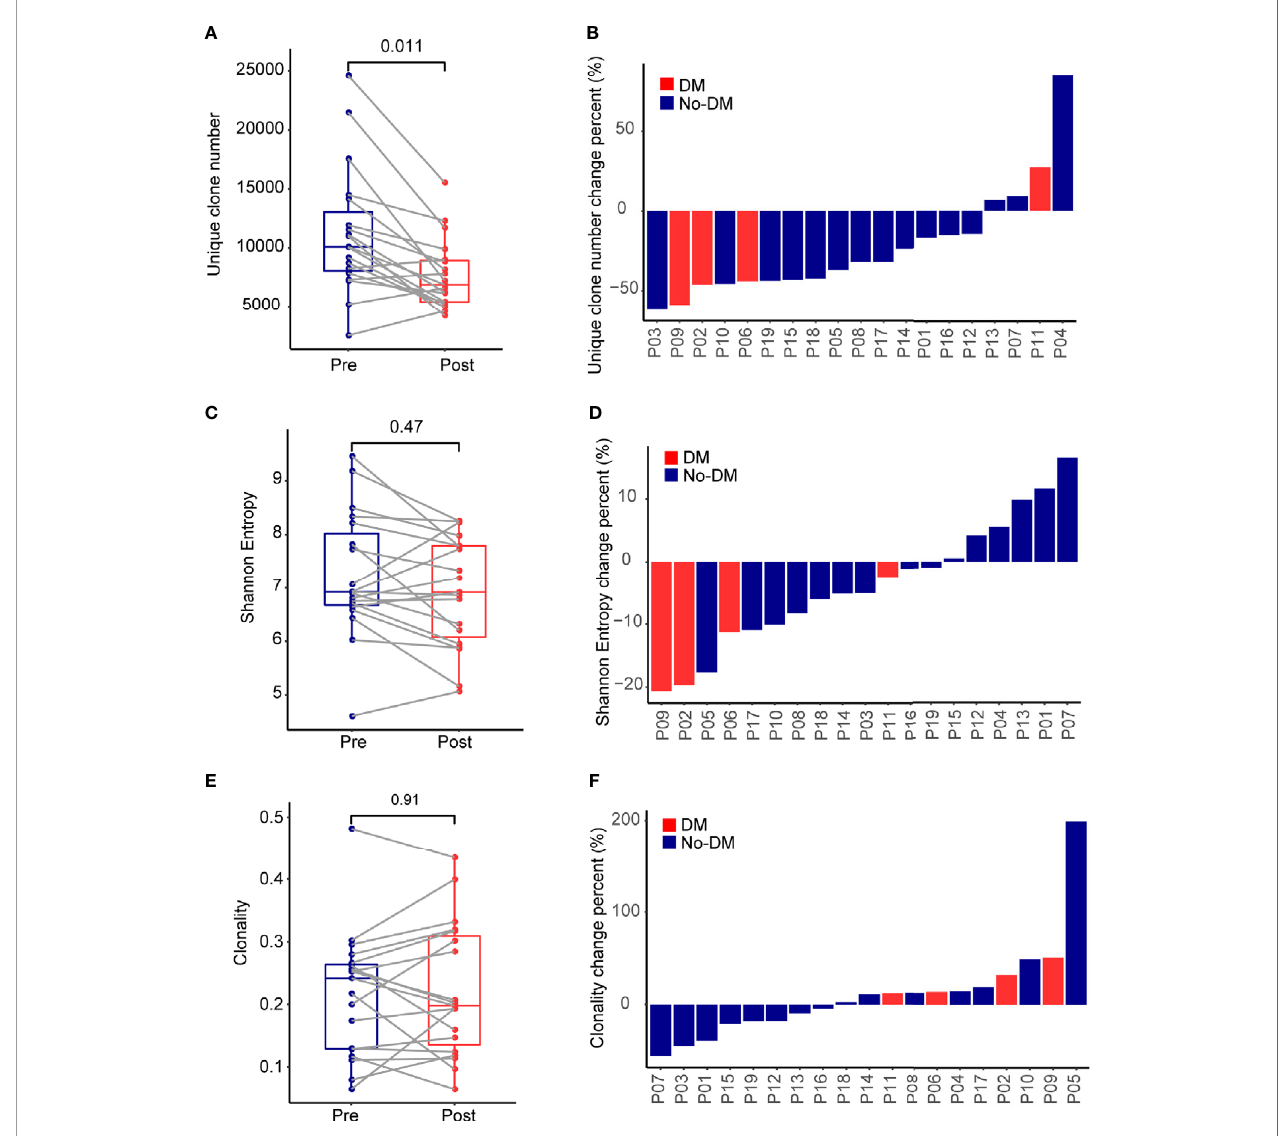
FIGURE 1 | Effects of stereotactic body radiotherapy (SBRT) on the immune repertoire. (A) Boxplots show the percentage change in number of unique TCR clones per patient from before (Pre) and after (Post) SBRT. Change is calculated as [(No. of TCR clones after SBRT minus No. of TCR clones before SBRT)/(No. of TCR clones before SBRT)]. (B) Waterfall plot showing percent changes in number of unique TCR clones after SBRT versus before SBRT per patient, calculated as described in (A) . (C) Boxplots show the percentage change in Shannon Entropy per patient [Shannon Entropy after SBRT minus Shannon Entropy before SBRT)/ (Shannon Entropy before SBRT)]. (D) Waterfall plot showing percent changes in Shannon Entropy per patient, calculated as described in (C) . (E) Boxplots show the percentage change in clonality per patient from before to after SBRT, calculated as [(Clonality after SBRT minus clonality before SBRT)/(clonality before SBRT)]. (F) Waterfall plot showing the percent changes in clonality, calculated as described in (E) . P values were calculated with Wilcoxon tests. For each panel, red indicates the 4 patients who developed distant failure (DM) after SBRT, and blue indicates the 15 patients without distant failure